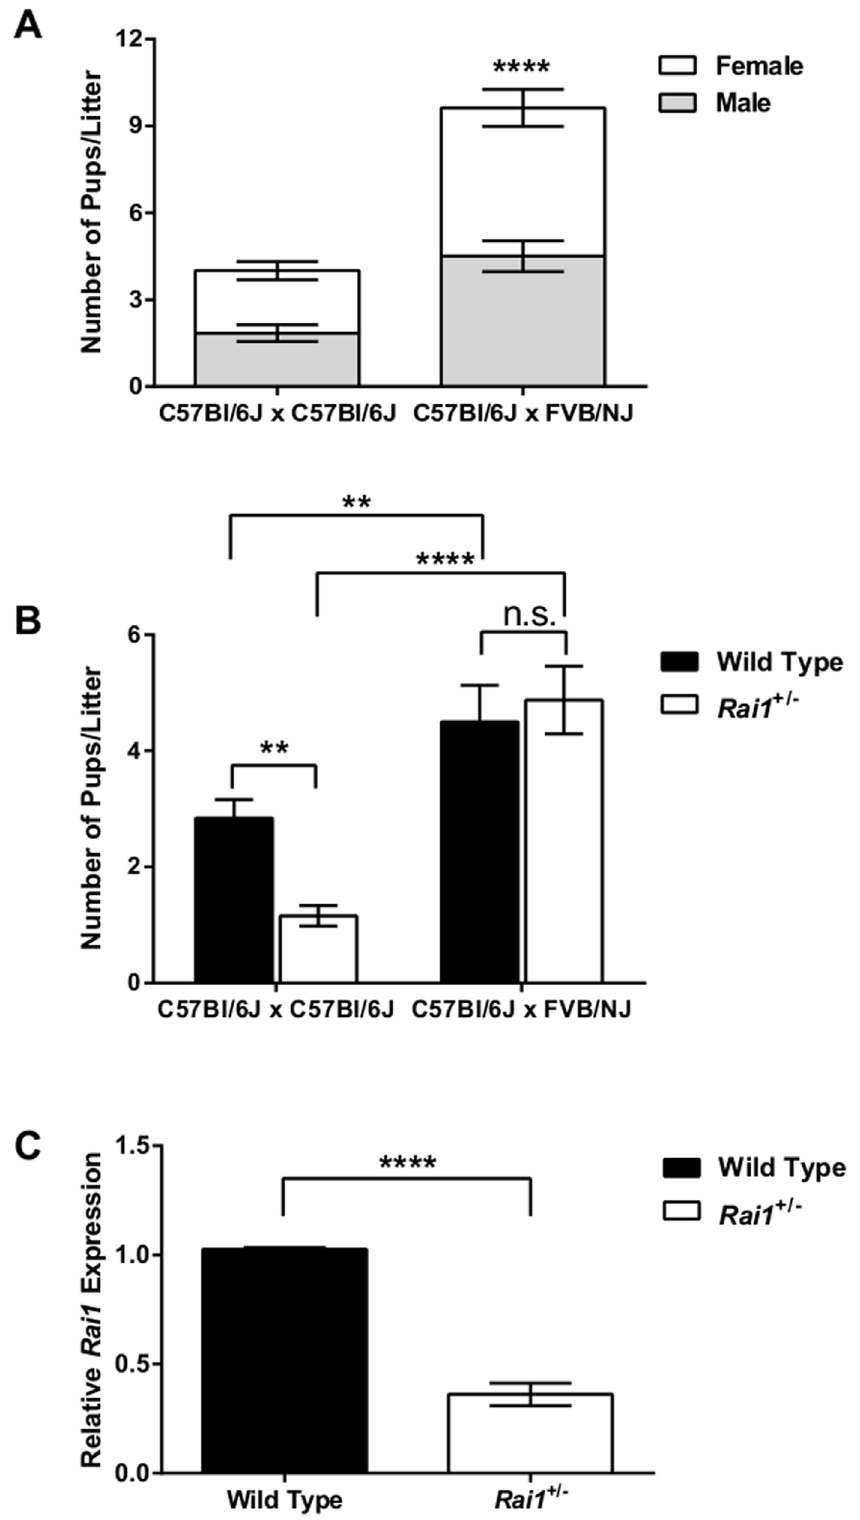
Figure 1. Rai1 + / 2 mice have improved fecundity in a FVB/NJ genetic background. ( A ). Rai1 + / 2 mice in the C57Bl/6J background when mated to C57Bl/6J produced significantly fewer progeny relative to Rai1 + / 2 mice mated to a FVB/NJ genetic background. In either background, the proportion of male and female progeny was not significantly different. No significant difference was observed for transmission of the Rai1 + / 2 allele by either parent (data not shown). ( B ). The number of Rai1 + / 2 progeny produced in a C57Bl/6J genetic background is significantly less than the number of wild type progeny produced, indicating altered Mendelian ratios; however, the number of Rai1 + / 2 progeny produced when mating occurs in the